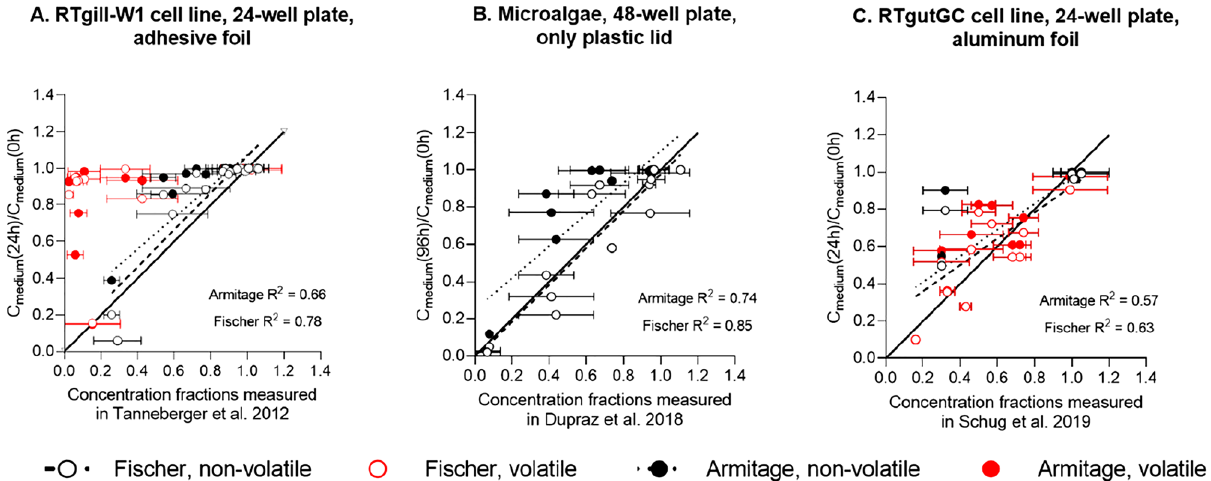
Figure 1. Comparison of measured and predicted chemical concentration fractions in exposure media, with predictions based on the Armitage (filled circles) and Fischer (empty circles) models. ( A ) 24-well plates covered with an adhesive foil (24 h RTgill-W1 cell line exposure, measured data from Tanneberger et al. 13 ), ( B ) 48-well plates covered with plastic lid (96 h microalgae exposure, measured data from Dupraz et al. 21 ) and ( C ) 24-well plates covered with aluminium foil (24 h RTgutGC exposure, measured data from Schug et al. 22 ). Red symbols represent volatile chemicals (i.e. logHLC > − 5.61, according to Tanneberger et al. 13 ). Solid line is a 1:1 correlation, dotted and dashed lines represent the regressions according to predictions by the Armitage et al. 14 and Fischer et al. 18 models, respectively (for adhesive foil the regressions of only non-volatile chemicals are shown). Tanneberger et al. 13 Dupraz et al. 21 Schug et al. 22 Endpoint Model Non-volatile c Volatile c Non-volatile c Non-vol. c Volat. c All d Armitage 14 0.66 R 2